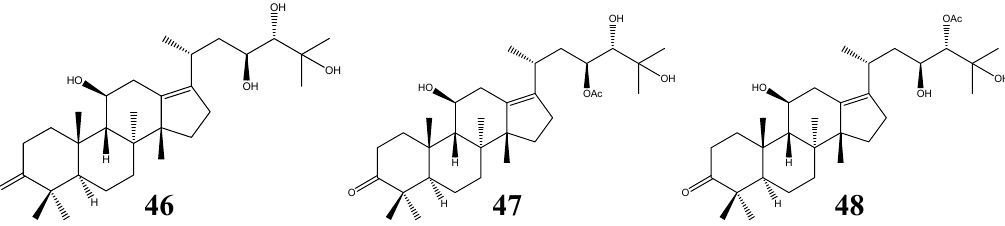
Figure 4. Structures of the alisol E series of